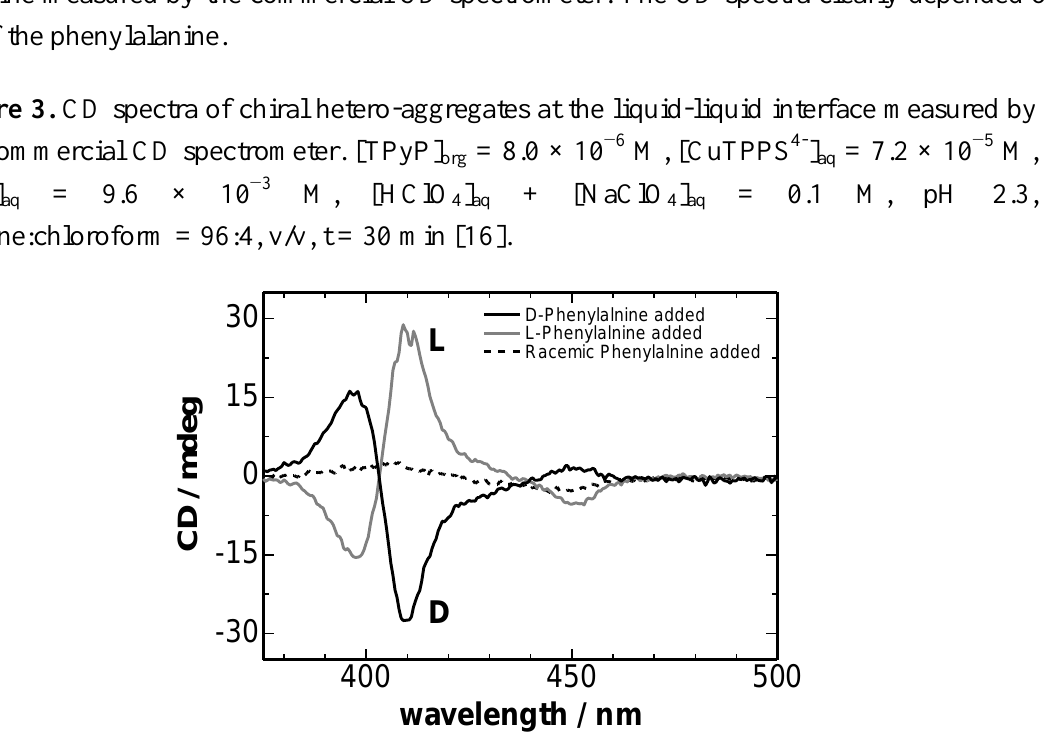
Figure 3. CD spectra of chiral hetero-aggregates at the liquid-liquid interface measured by the commercial CD spectrometer. [TPyP]